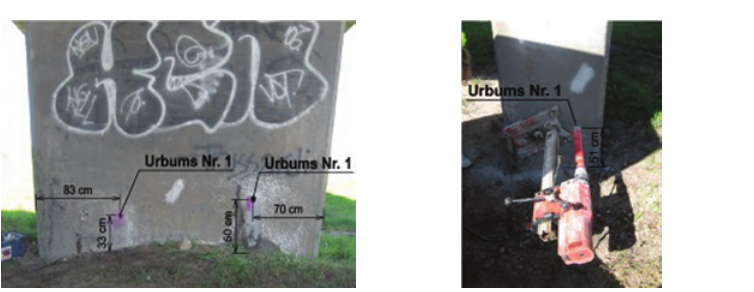
fig. 10. Ramp No. 5 pier and sampling location